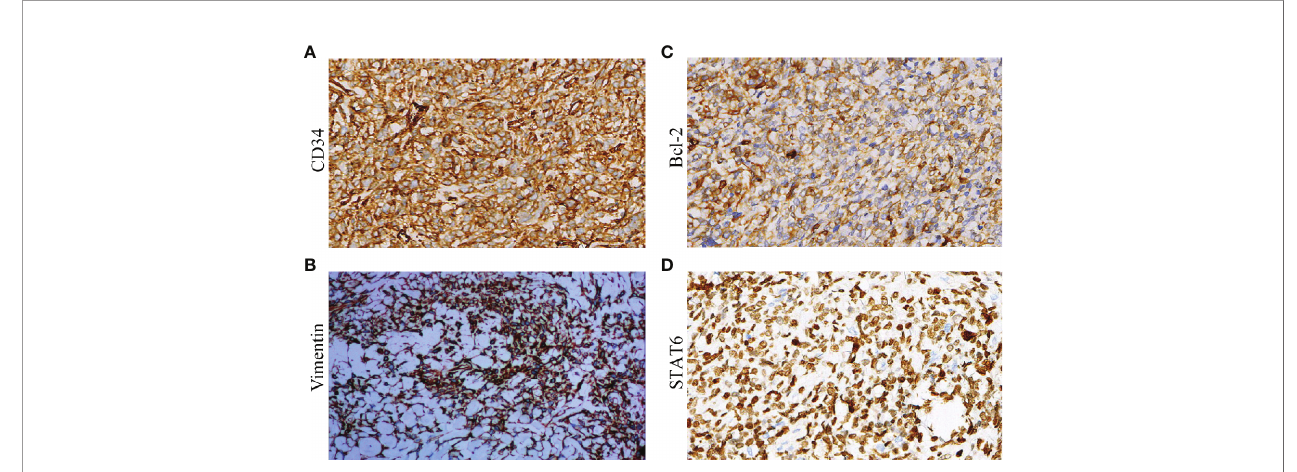
FIGURE 3 | Immunohistochemistry of biological markers for SFTP: (A) CD34; (B) Vimentin; (C) Bcl-2; and (D)